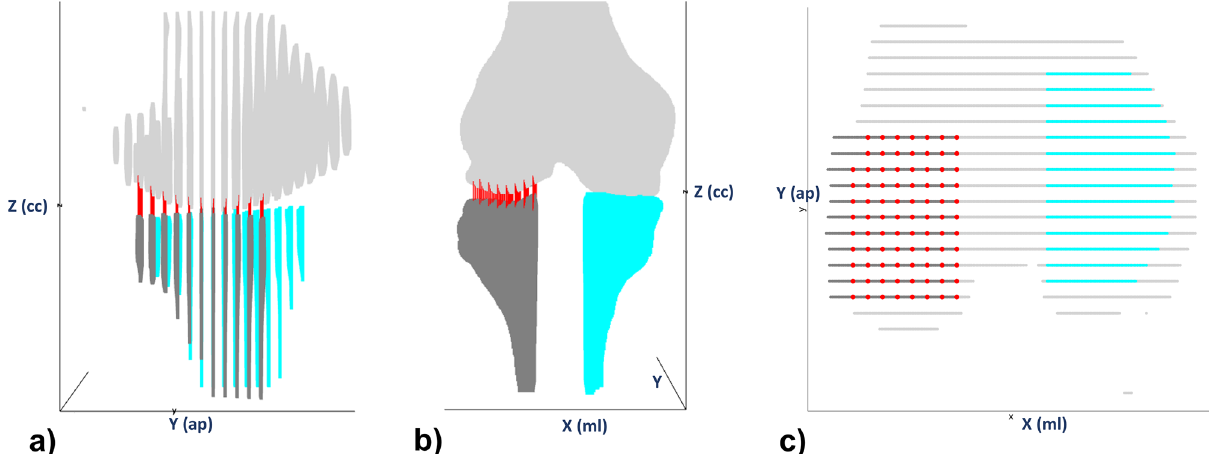
Figure 7. Computational measurements of subchondral cortical distances based on joint-specific 3D models. After manual segmentations of the femur (light grey) and the tibia (dark grey [lateral]; turquoise [medial]), the segmentation outlines were transferred to specific Cartesian coordinate systems (angulated along the z-axis as defined by the tibial bone axis) and used as 3D models for each joint, configuration, and condition. Grids with fixed spacings were used to standardize measurement locations of the subchondral cortical distances (red lines) that were computed parallel to the z-axis. X-, y-, and z-axes indicate the mediolateral (ml), anteroposterior (ap), and craniocaudal (cc) dimensions. Accordingly, the y–z-, x–z-, and x–y-planes represent the sagittal ( a ), coronal ( b ), and axial orientations ( c ). The sliced appearance of the 3D models in ( a ) and ( c ) is due to interslice